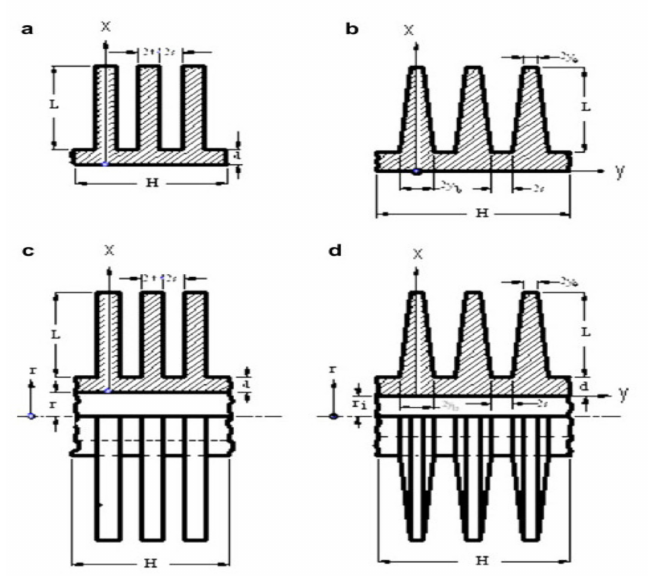
Figure 10. Various types of fins ( a ) LRFA, ( b ) LTFA, ( c ) ARFA, and ( d ) ATFA [90] © Elsevier,